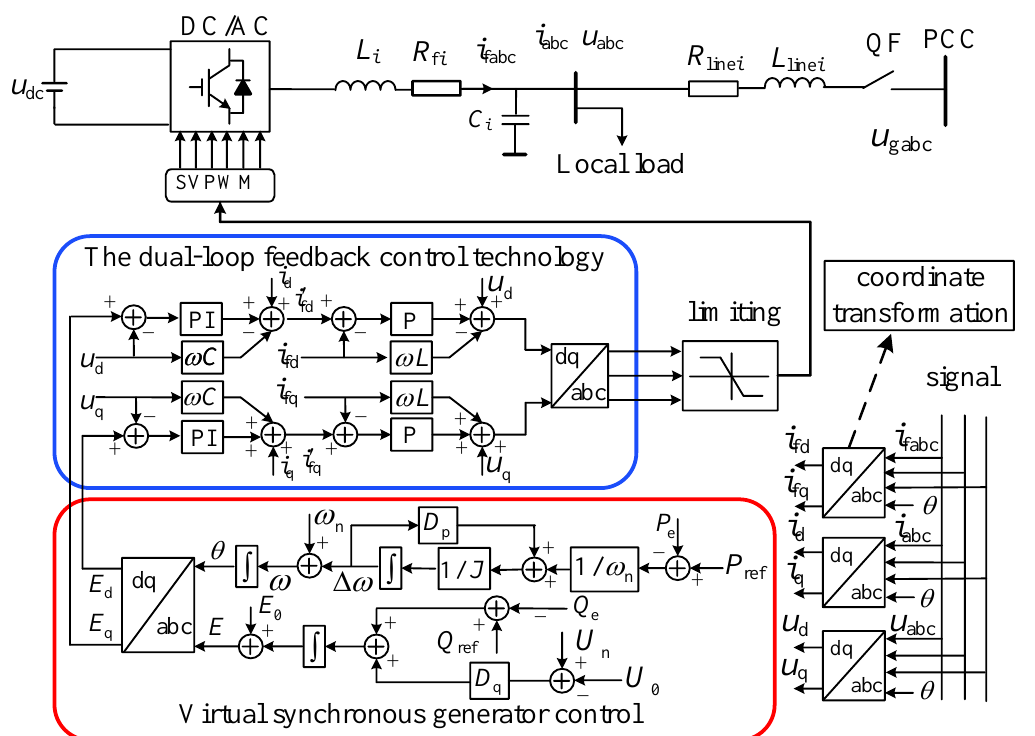
Figure 2. Control structure block diagram of virtual synchronous generator .